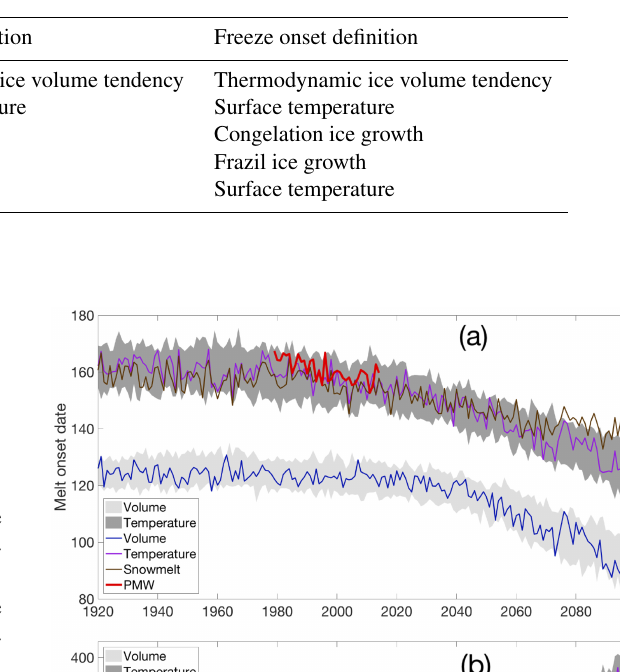
Table 2. CESM LE definitions for melt season length, showing the various melt and freeze onset definition combinations used to compute melt season length. For each combination, the melt onset date is subtracted from the freeze onset date at each grid cell every year.